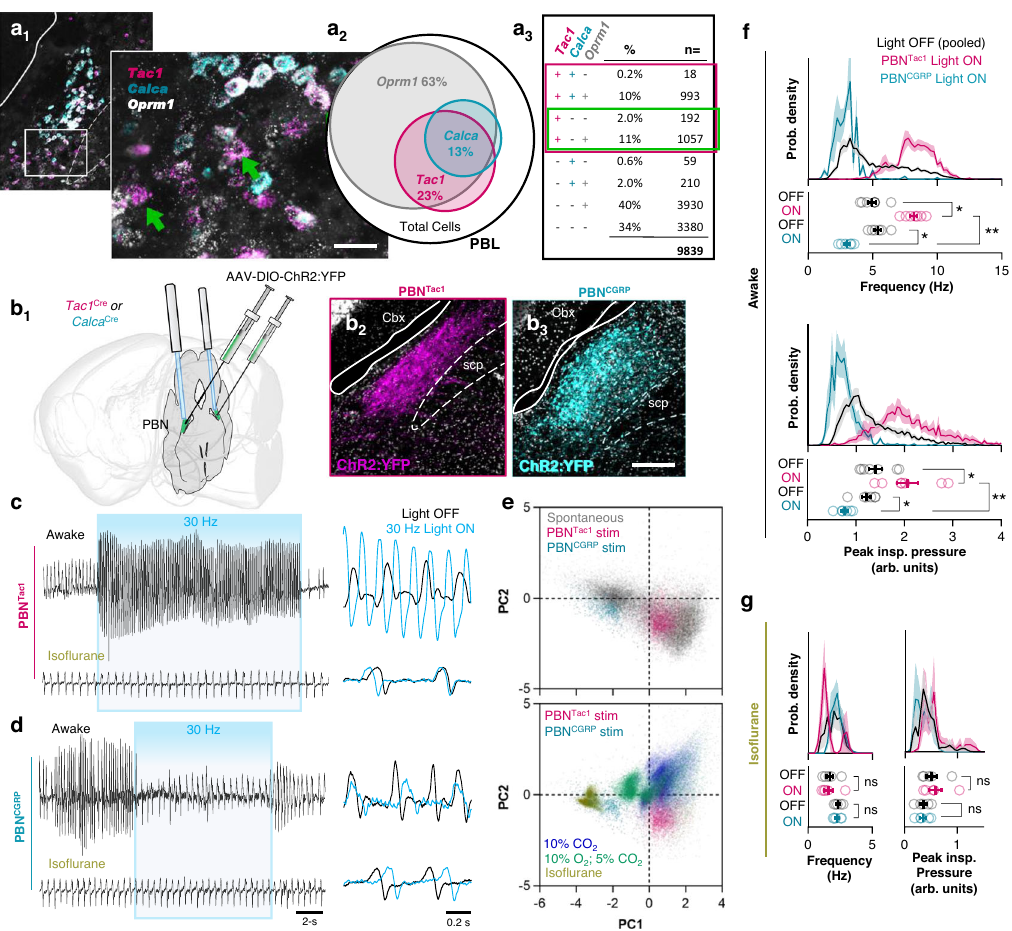
d Same as c but during photoactivation of PBN CGRP neurons. Scale bars in c also Fig. 2 | Peptidergic PBN subpopulations have opposing effects on breathing. a Example RNAscope images illustrating partially overlapping Tac1 , Calca , and apply to d . e PCAcomparing spontaneous breathing patterns (22,351 breaths from Oprm1 populationsinthePBL(a n =6 mice) to breathing patterns during photoactivation of PBN Tac1 (3,507 breaths 1 )withVennDiagram(a 2 )andtable(a 3 )showingthe estimated size of each subpopulation as a fraction of total PBL cells ( n =9839 cells density histograms (top) and mean values from each mouse (bottom; n =7 Tac1, analyzed from n =3 mice). Green arrows in a 1 and green box in a 3 indicate Tac1 n =6 CGRP) comparing breathing frequencies and peak inspiratory pressures neurons that do not co-express Calca . Scale bars=40 µ m and 20 µ m (zoomed). b Schematic of viral gene transfer approach (b 1 ) and recombinase-dependent during photoactivation of Tac1 or CGRP PBN neurons. Tac1 and CGRP data were pooled for the light OFF condition shown in the probability density histograms. expression of ChR2:YFP in Tac1 (b 2 ) or CGRP (b 3 ) PBN neurons representative of n =7 (Tac1) or n =6 (CGRP) mice. Scale bar=200 µ m. scp superior cerebellar peduncle, Cbx cerebellar cortex. c Representative plethysmograph recordings from a mouse when awake (top) and lightly anesthetized with 1.5% iso fl urane f ). * p <0.05; ** p <0.01. Means±SE. Source data and statistical details provided in (bottom) during photoactivation of PBN Tac1 neurons for 15s at 30Hz. Panels on right show overlay of 1s of breathing with light OFF (black) and light ON (blue). Source Data fi